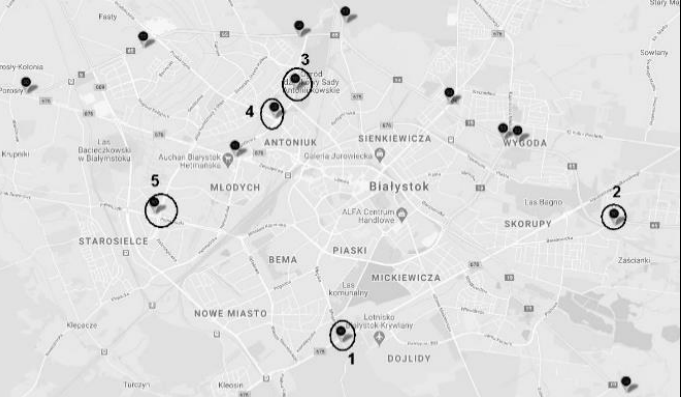
Figure 2. Location of VMSs in Bialystok.